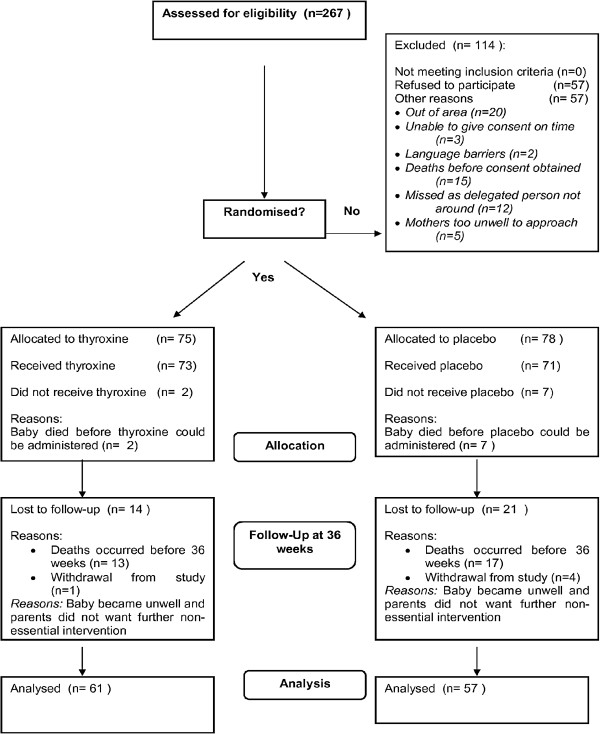
Consort diagram.